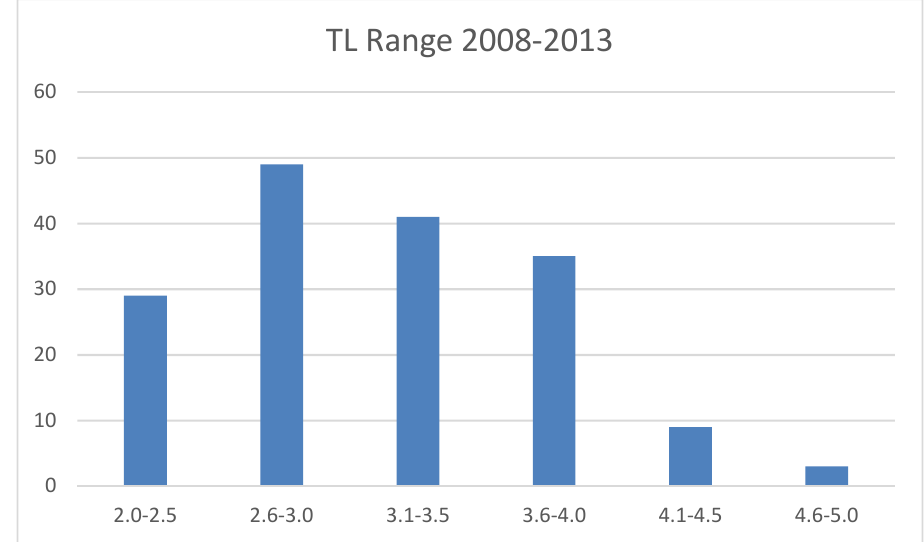
Figure 4. Total length range (meters) of white sharks, between 2008 and 2013.